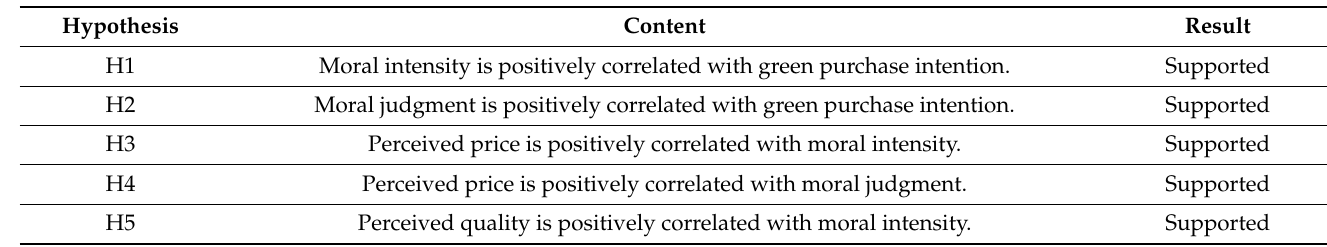
Table 5. Results summary for each